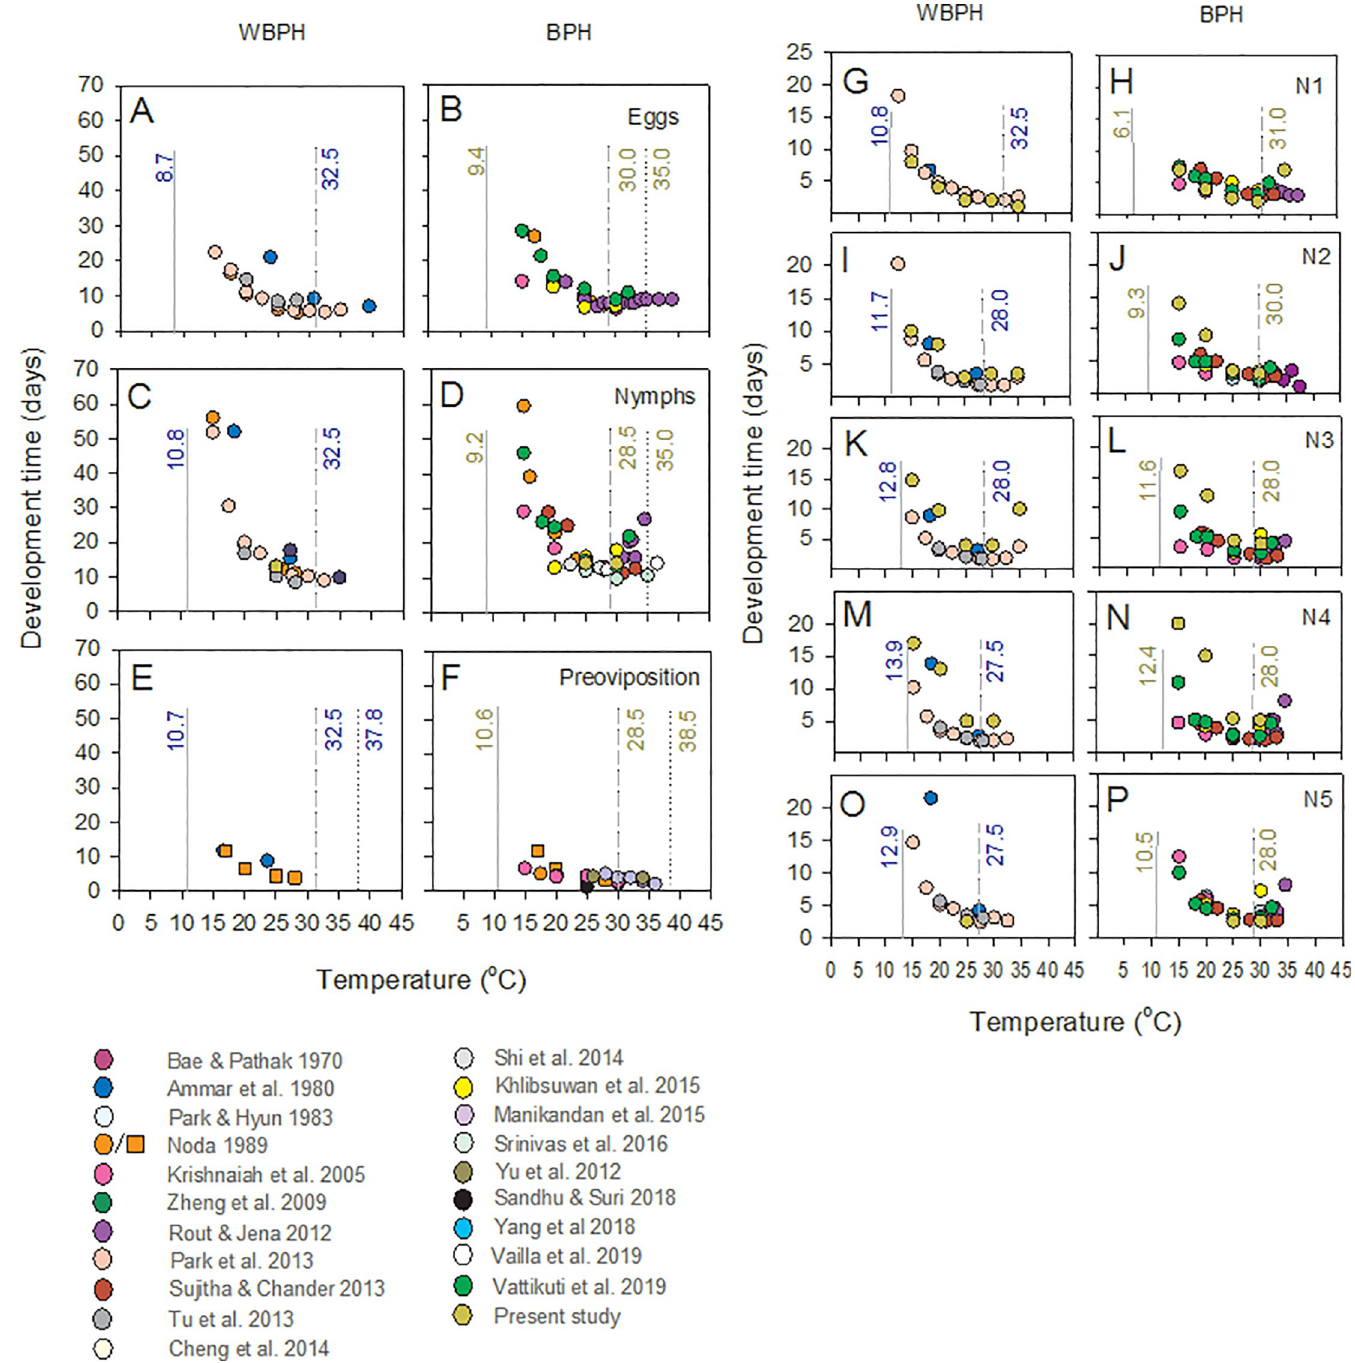
Fig 8. Temperature thresholds for development of BPH and WBPH. Responses to temperature for egg development in (A) WBPH and (B) BPH, nymph development in (C) WBPH and (D) BPH and the development of pre-ovipositional adult females of (E) WBPH and (F) BPH are indicated. Responses are based on published studies and include data from the present study. Development of first (G,H), second (I,J), third (K,L), fourth (M,N) and fifth (O,P) instars are also shown for WBPH (G,I,K,M,O) and BPH (H,J,L,N,P). Thresholds for developmental zero (solid lines), the limits of linear temperature-related increases in development (dashed lines), and maximum critical temperatures (dotted lines) are indicated where available. Numbers are thresholds for WBPH (blue) and BPH (brown)(see also Tables 1 and 5). Colored symbols represent data sources as indicated in the legend (see also Fig 1 for population sources).